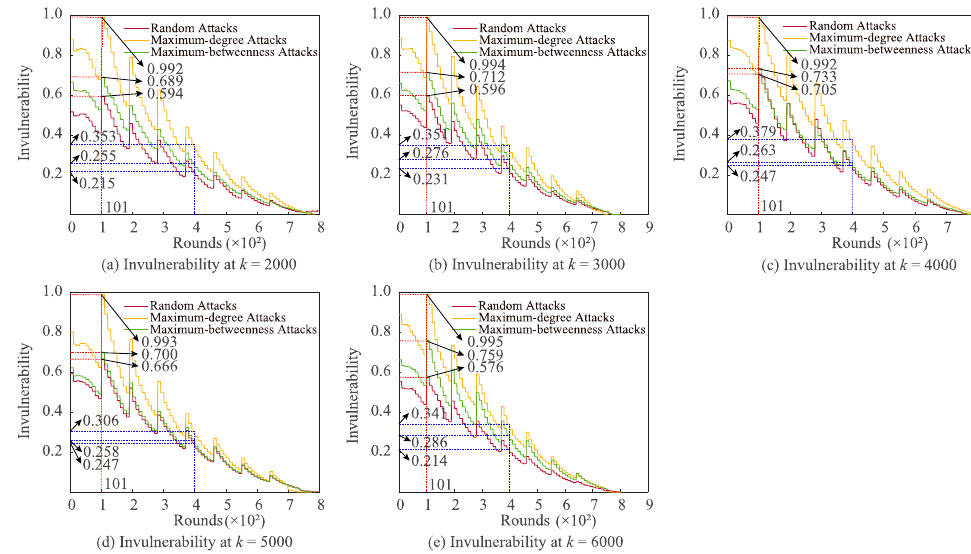
Figure 3. Effects of changing k on invulnerability for varied attacks.